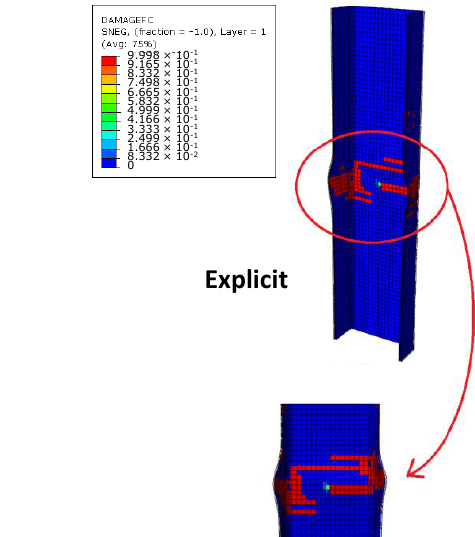
Table 5. Investigated element formulations. Model Name